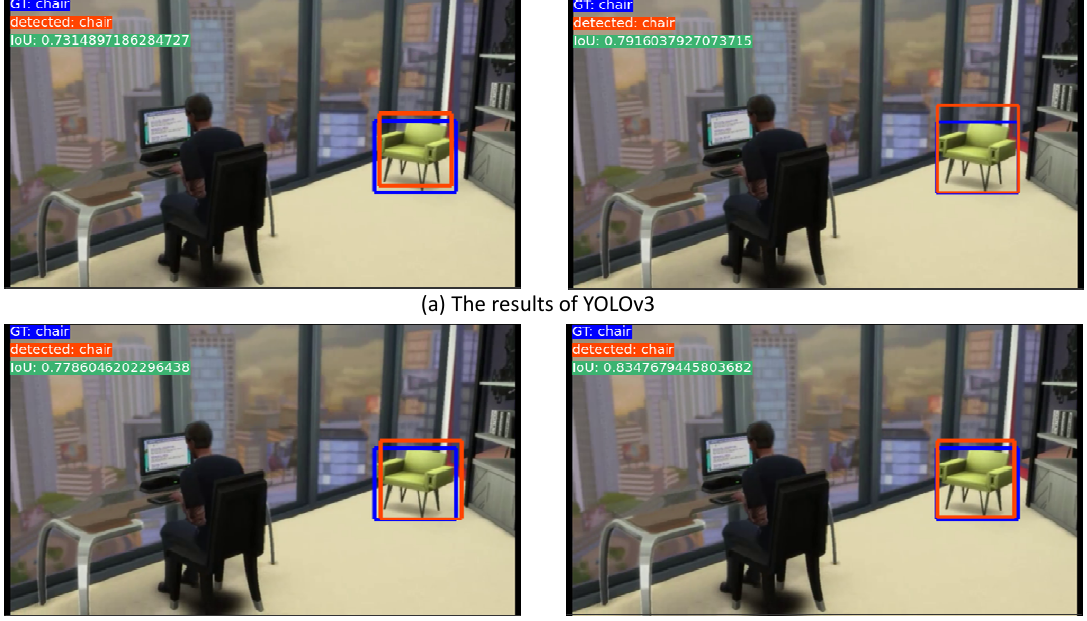
Figure A1. Comparison of the bounding box detection on game 7 Days to Die . The left column is the result from the models trained by PASCAL VOC and the right column is the result from the models trained by PASCAL VOC and game